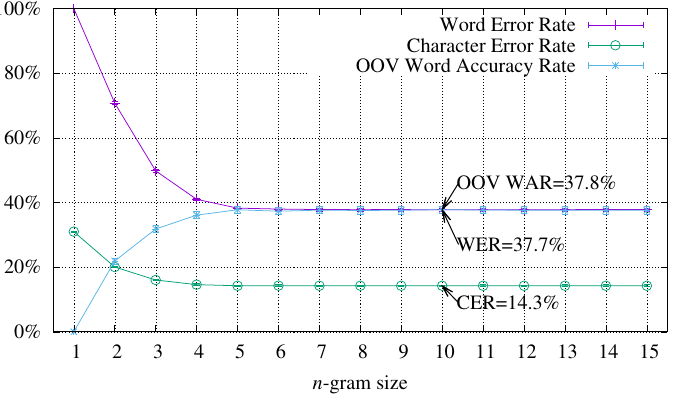
Figure 16. Results obtained by the RNN character-based system using n -gram language models.